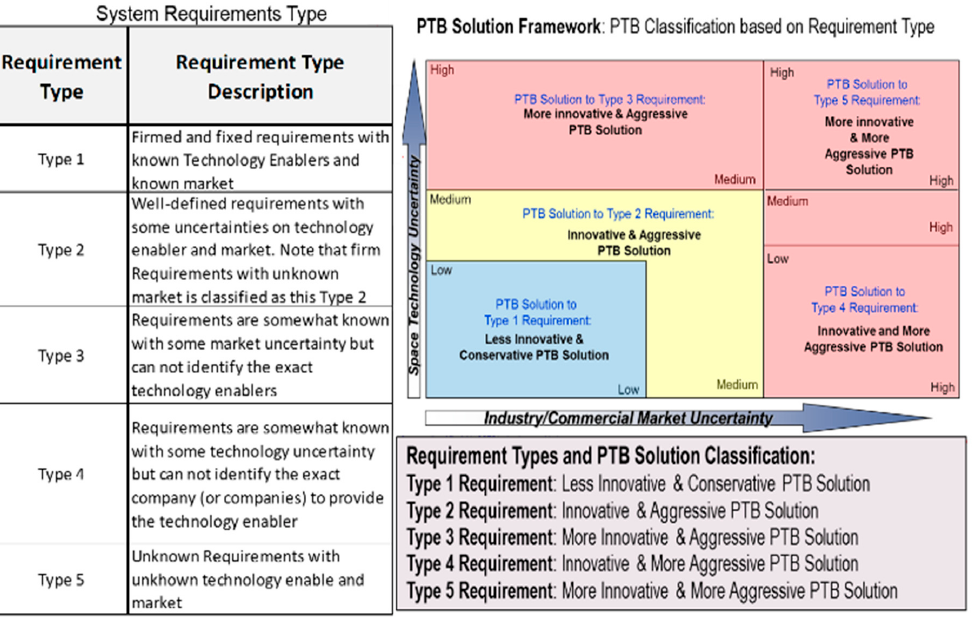
Figure 4. Program and Technical Baseline (PTB) Solution Framework for Classifying PTB Solution Per Requirement Uncertainties [6].